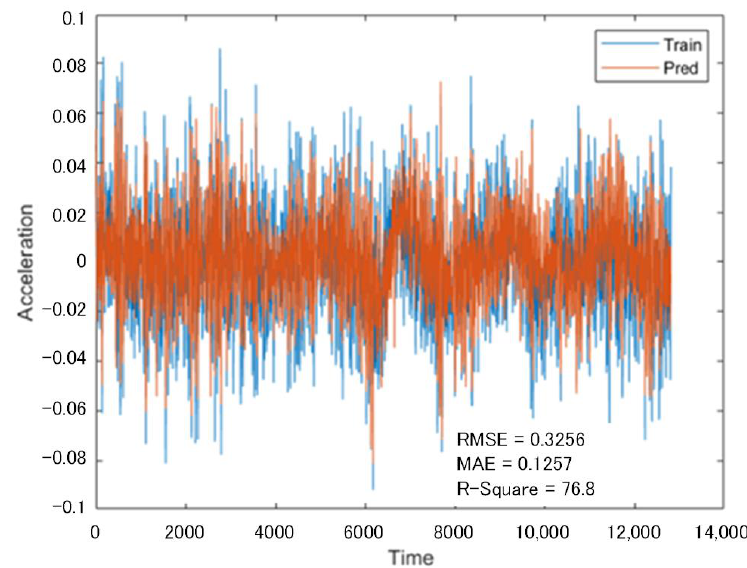
Figure 9. Comparison of vibration acceleration from Channel 7.